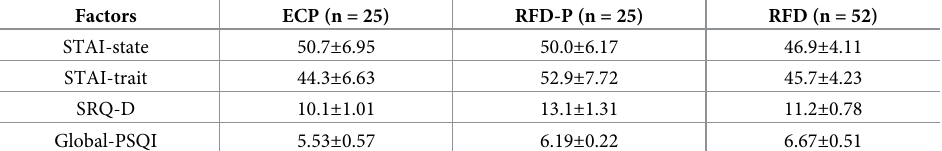
Table 2. Comparison of STAI, SRQ-D and global PSQI scores among ECP patients, RFD-P patients and RFD patients.